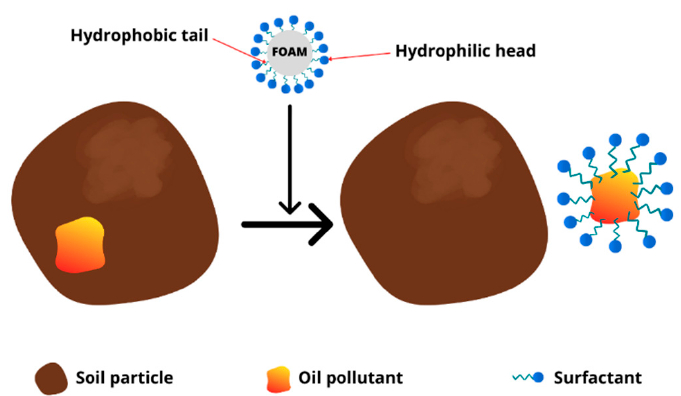
Figure 4. Use of surfactant foam to remove organic contaminants in soil.